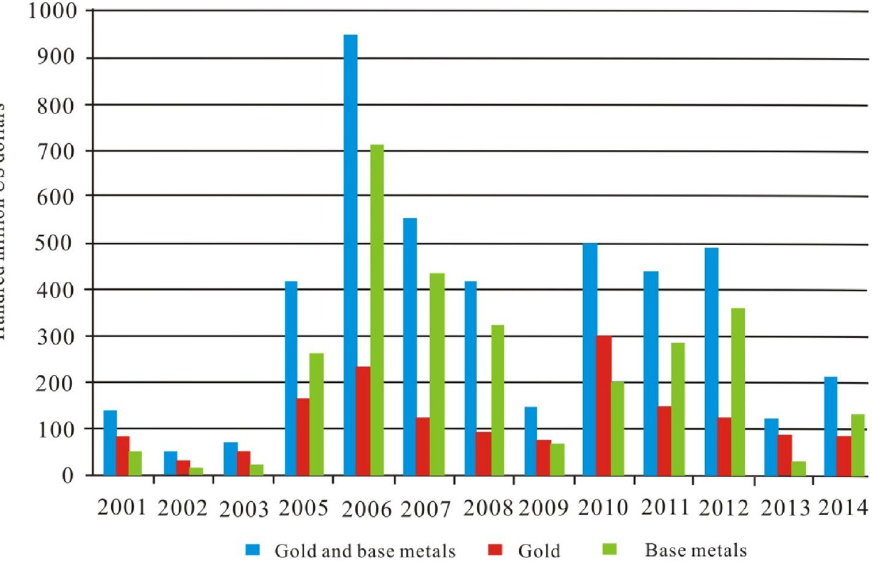
Figure 1. Trends of global mining investment for China’s mining companies in the past 10 years ( Source: SNL